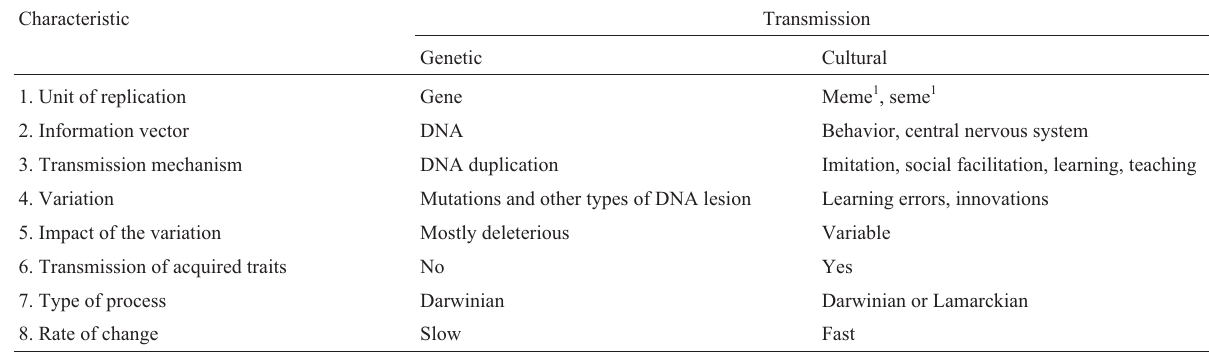
Table 3 - Comparison between the genetic and cultural